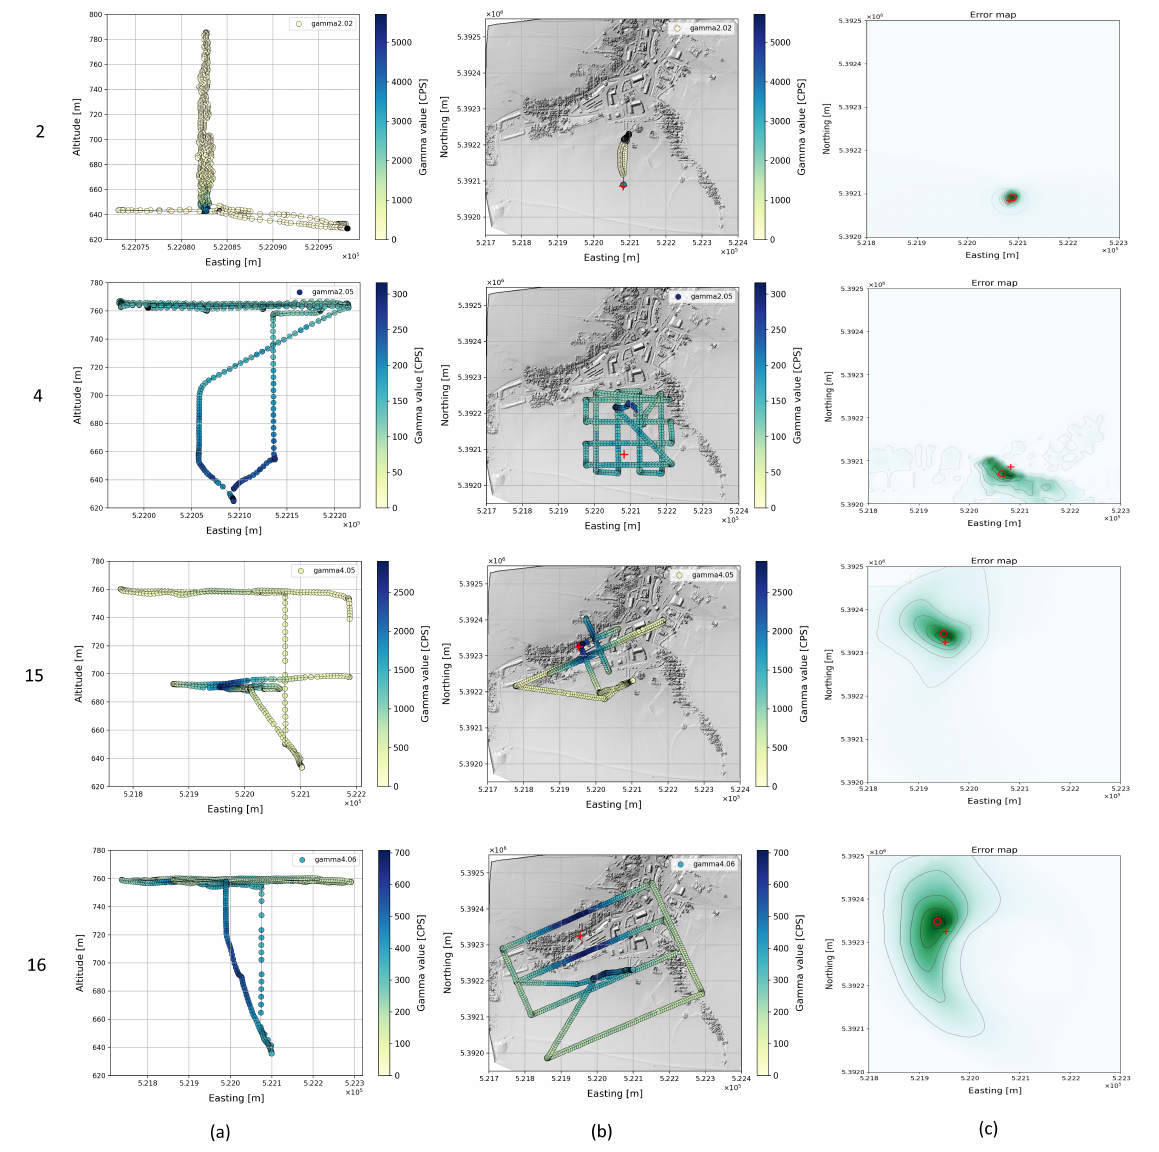
Figure 7. Flight pattern for selected flight (2, 4, 15, 16) with single radioactive source projected to xz-plane ( a ) and projected to ground xy-plane ( b ). The gamma measurements are color-coded. The corresponding cost map is shown in ( c